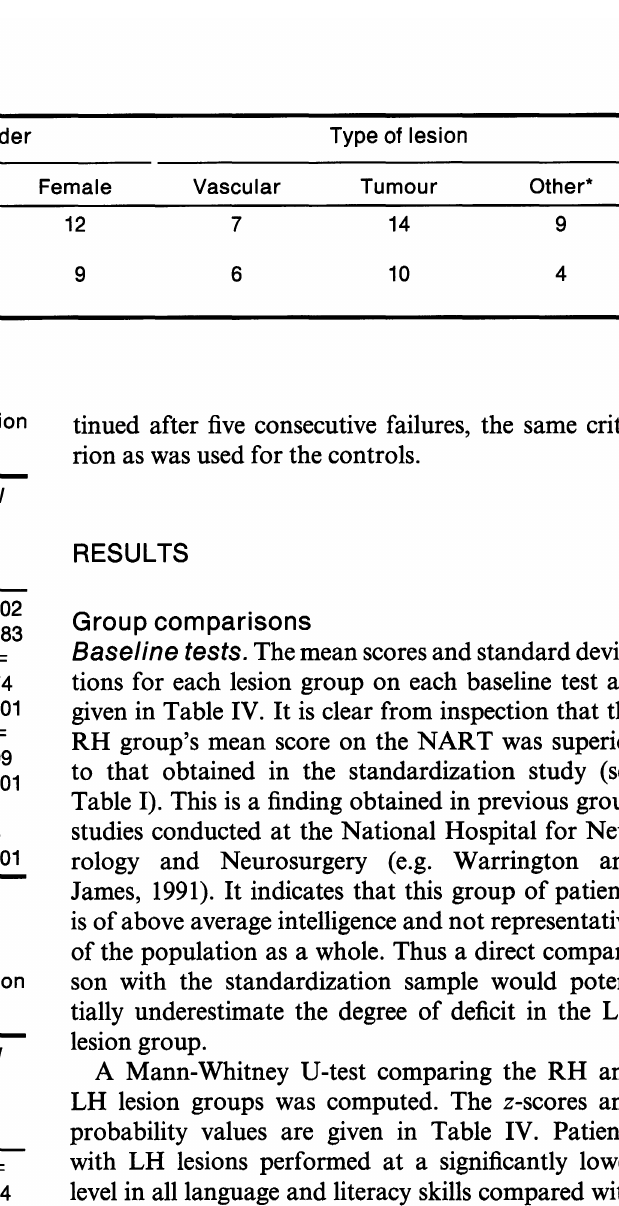
Spell A (max. score = 30) Spell B